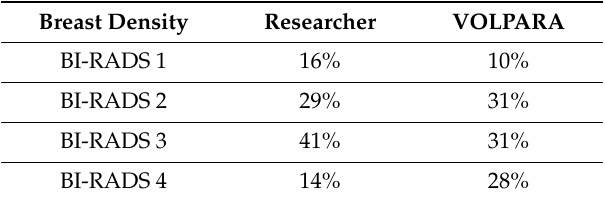
Table 2. The distribution of BI-RADS categories for the 122 cases according to the researcher and